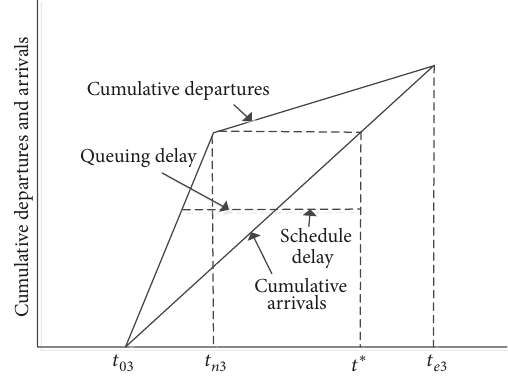
Figure 1: Cumulative departures and arrivals at equilibrium in Case